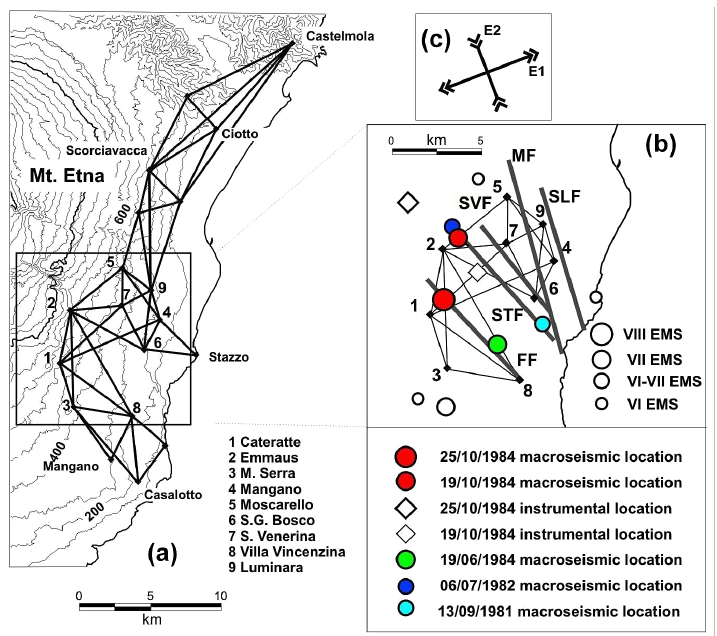
Figure 2. Ionica EDM network. (a) EDM benchmarks and lines measured between 1977 and 1985. (b) Macroseismic epicenters of earth- quakes with epicentral intensities I0 ≥ VI EMS occurring from 1980 to October 1984 in the southeastern flank of Mt. Etna. (c) Principal strain axes obtained from the comparison of the overall measurement interval 1980–October 1984. FF is Fiandaca Fault, STF is Santa Tecla Fault, SVF is Santa Venerina Fault, MOF is Moscarello Fault, and SLF is San Leonardello